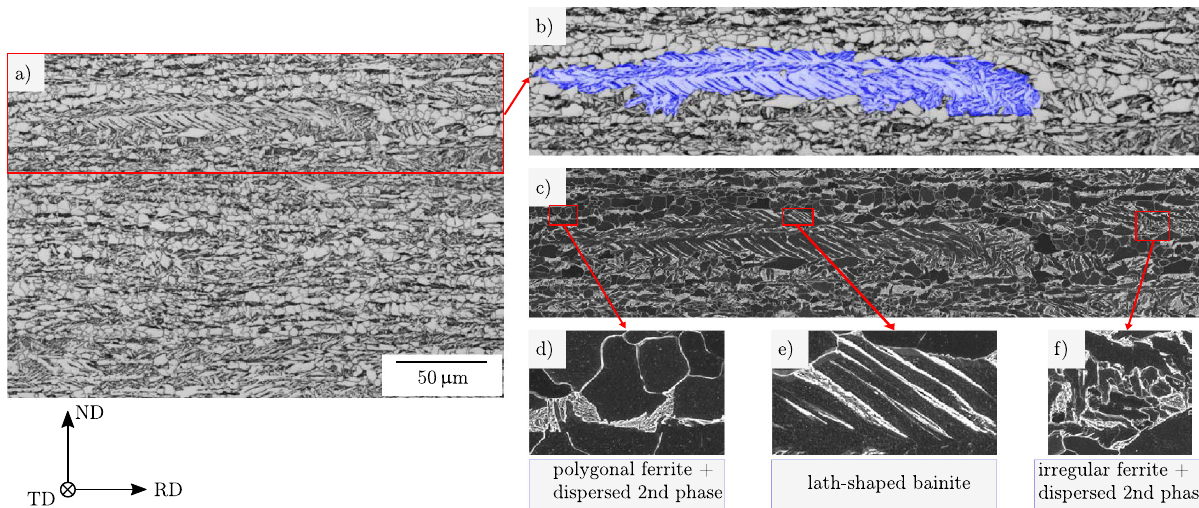
Fig. 7 Overview of microstructure and contained phases. a LOM micrograph of CP steel microstructure after Nital etching. b enlarged detail from ( a ), showing an annotated lath-shaped bainite region (blue). c correlative SEM micrograph of ( b ). The enlarged detail fi gures d – f depict polygonal ferrite with dispersed carbon-rich 2nd phase, lath-shaped bainite, and irregular ferrite with dispersed carbon-rich 2nd phase, respectively. In the SEM modality, the carbon-rich 2nd phase particles appear bright. RD, TD, and ND refer to the rolling, transverse and normal direction of the plate,